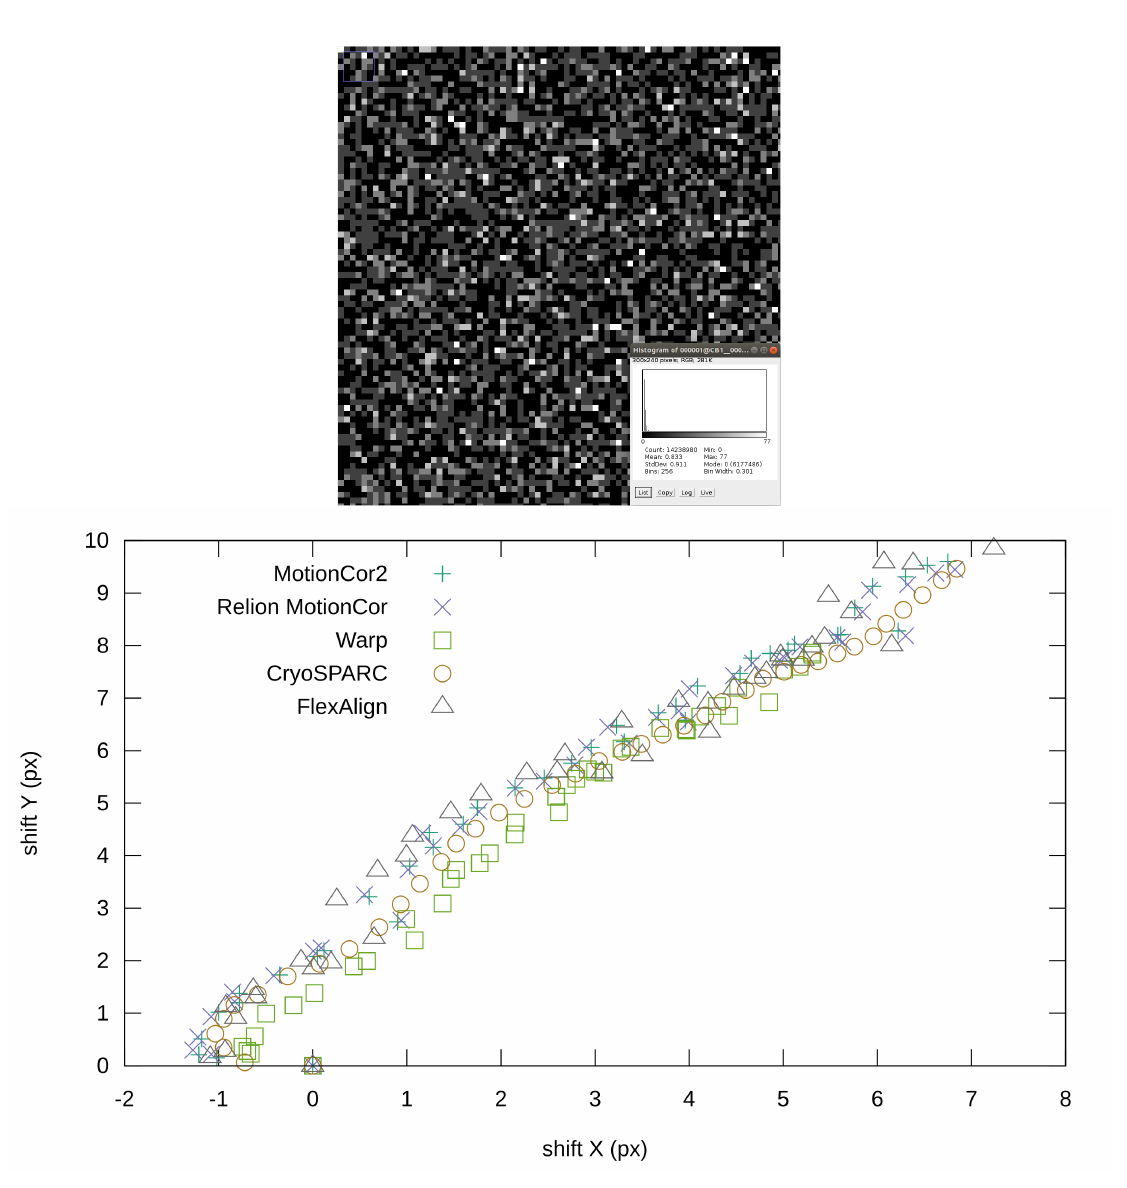
Figure 8. Detail of the frame from the EMPIAR 10288 (normalized) with histogram (before normalization) ( top ), reported global shifts by different programs ( bottom